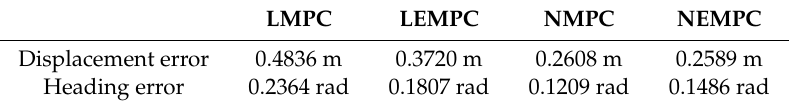
Table 10. The maximum absolute values after weight changing, with the positioning error in ± 0.2